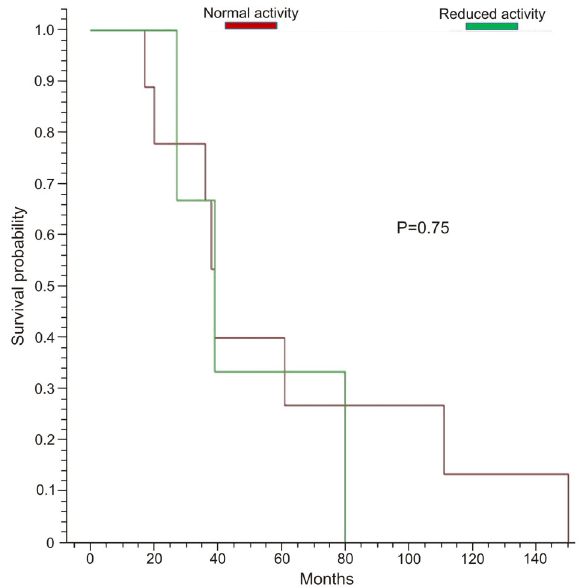
Figure 1. Disease-free survival was estimated using the Kaplan- Meier method and defined as the period between diagnosis and local or distant recurrence. Survival curves between phenotypic groups were compared using the log-rank test. P=0.75, not statistically